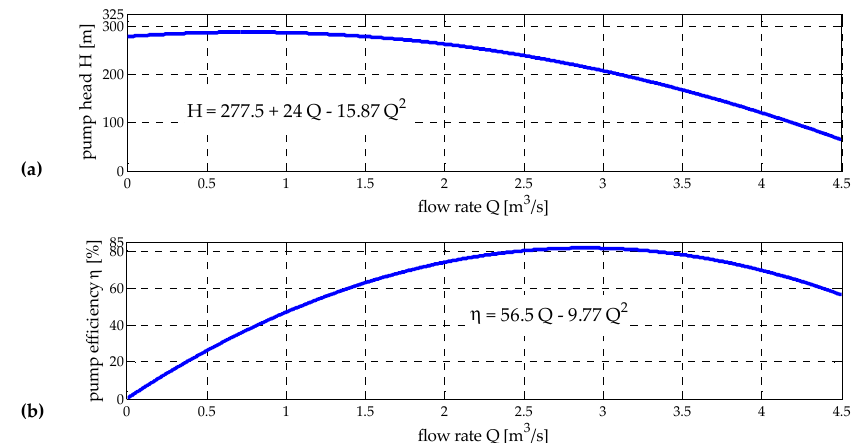
Figure 3. Pump characteristic curves used in the numerical model: ( a ) Head—flow rate curve; ( b ) Efficiency—flow rate curve.